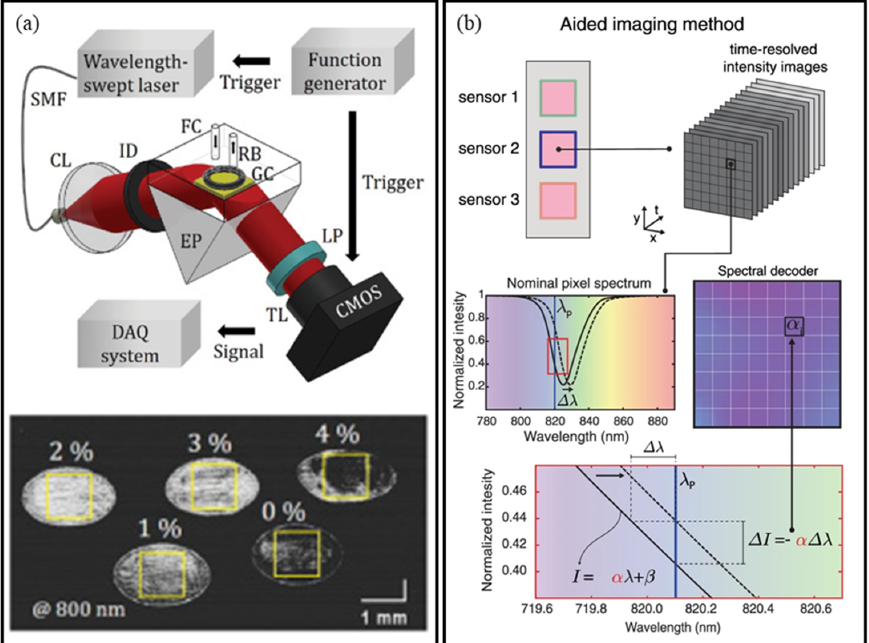
Figure 4. Optofluidic imaging of biochemical analysis. ( a ) Real-time SRP imaging using a wavelength-swept laser with a large area. ( b ) Biosensing according to the reconstructed spectral shift derived from the optimal linear estimator algorithm and the time-resolved intensity images. ( a ) Reprinted with permission from ref [60], Copyright 2018, OPTICA Publishing Group. ( b ) Reprinted with permission from ref [61], Copyright 2021, Nature Publishing Group.